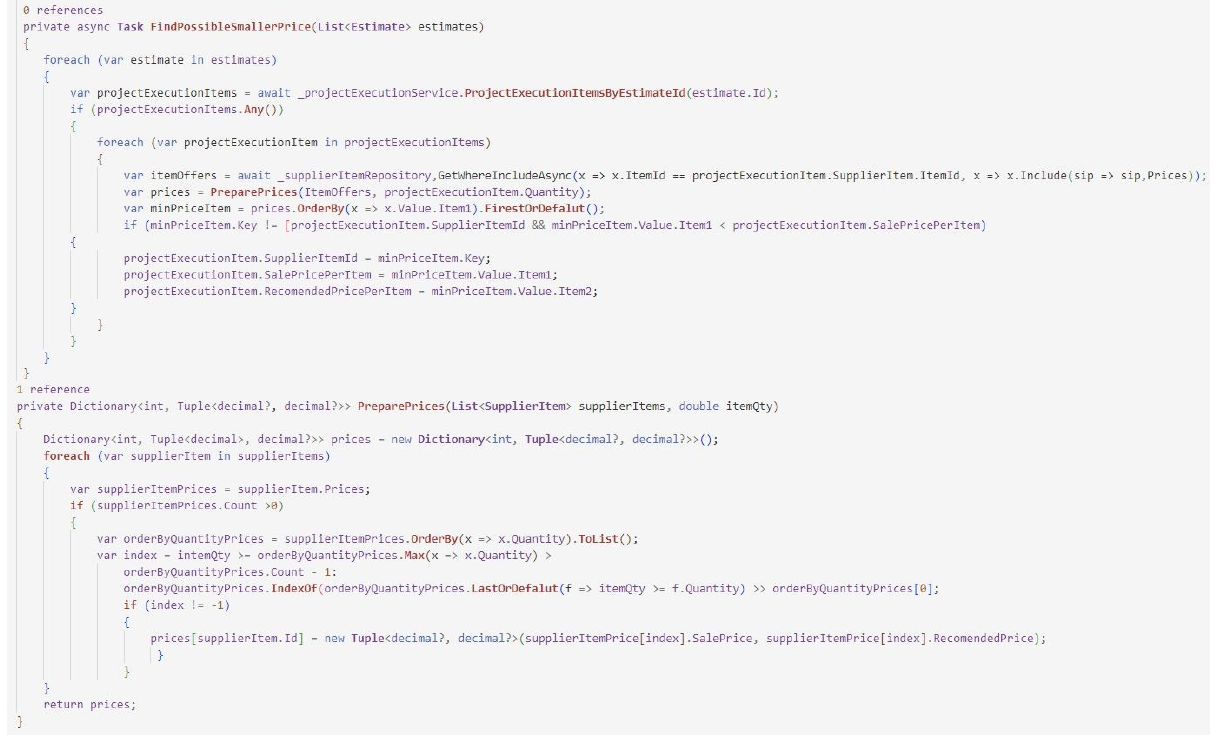
Figure 10. Pseudocode for designing intelligent algorithms for cost efficiency.